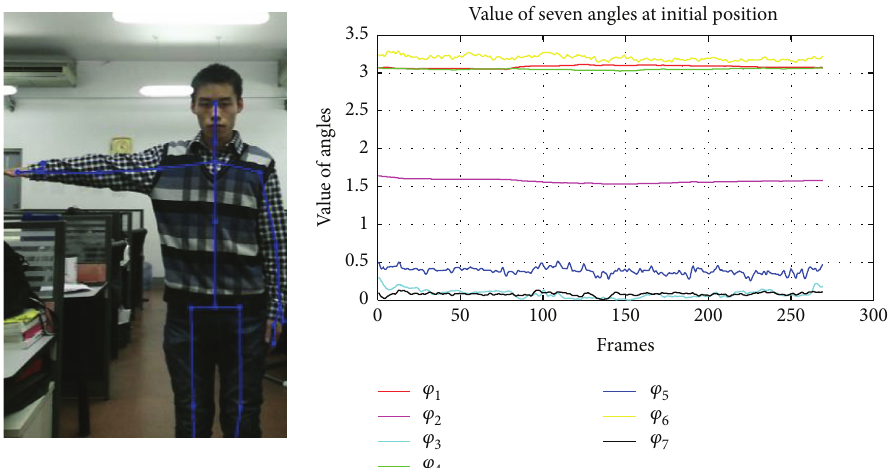
Figure 5: The initial positions of all joint angles. Operator stands statically in front of Kinect and keeps his upper and lower arm in a line and horizontal just as showed in the left picture. The right picture presents the variation of 7 joint angles in successive